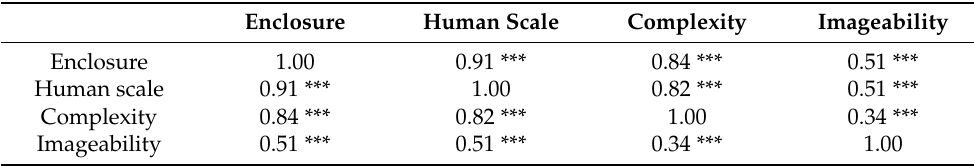
Table 3. Pearson correlation of four subjectively measured